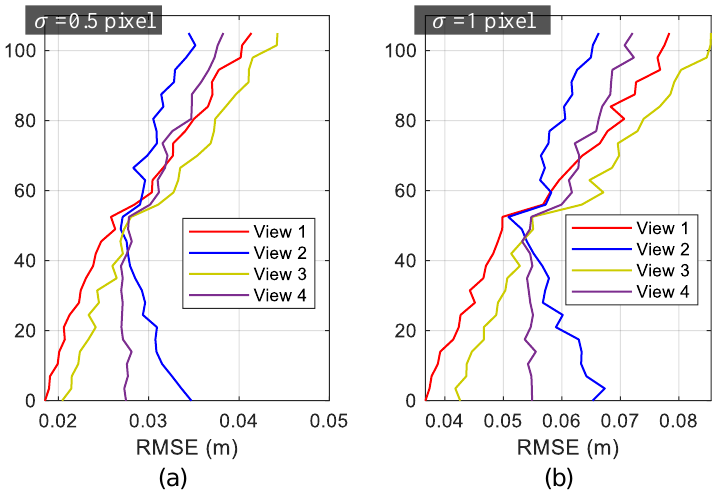
Figure 11. RMSE for each story: ( a ) σ = 0.5 pixel ( b ) σ = 1